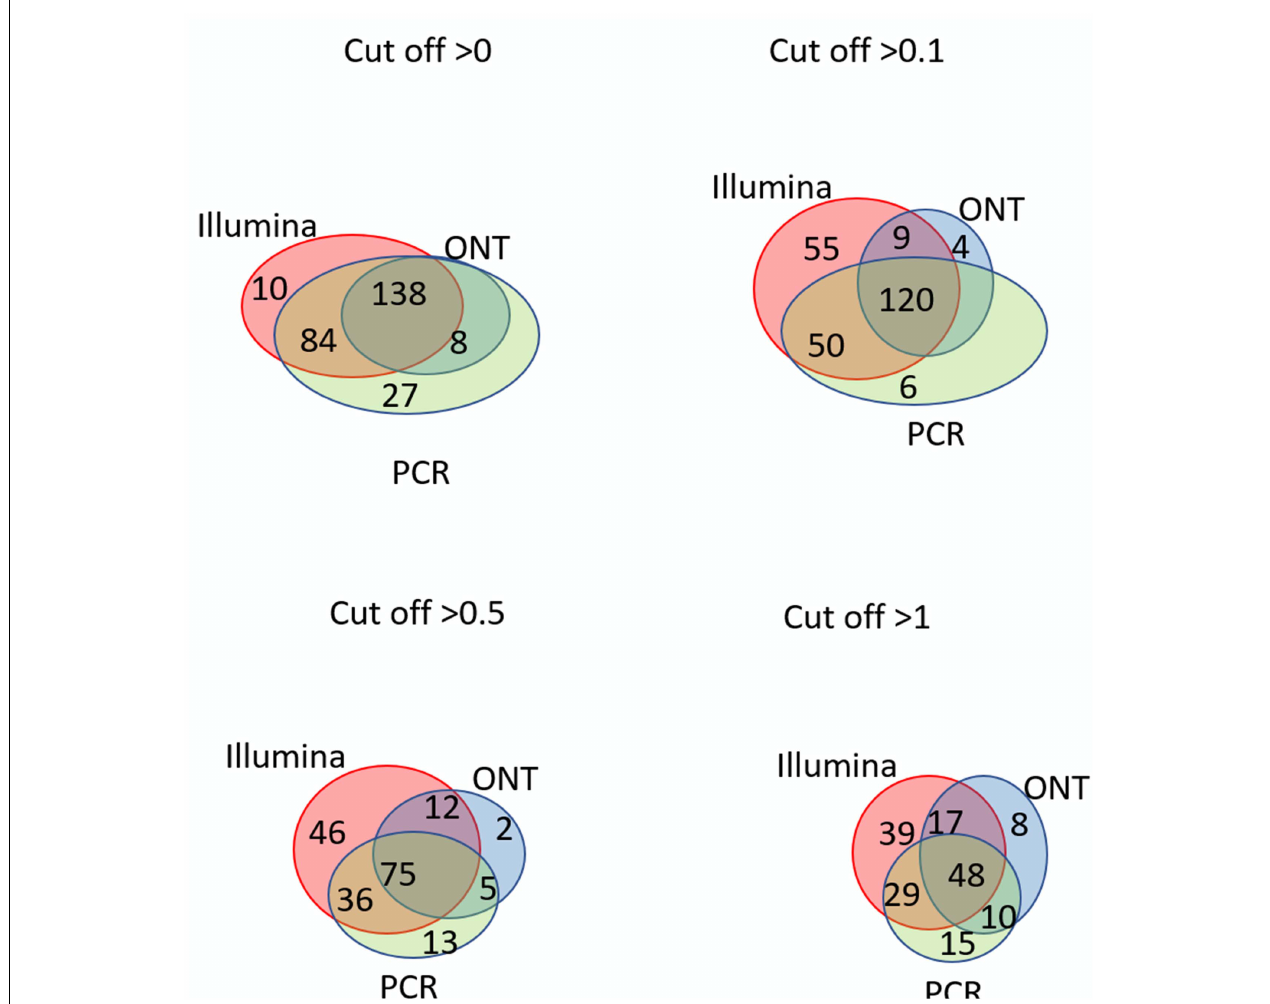
FIGURE 4 | Venn diagrams showing the detection of chromosome 18 transcripts in the liver by the Illumina, ONT, and qPCR platforms depending on the selected cutoff level.